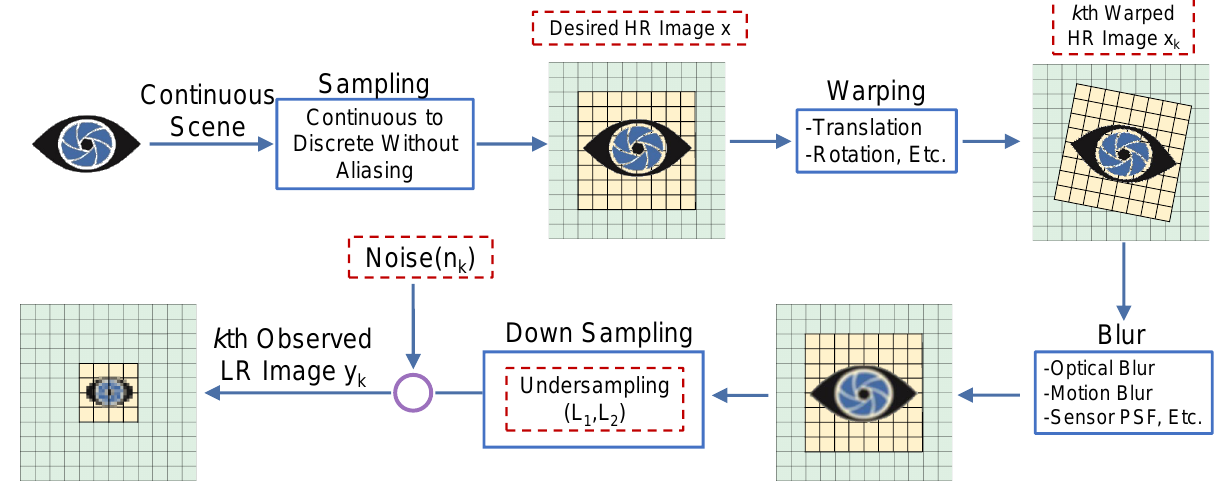
Figure 2. Image super-resolution forward